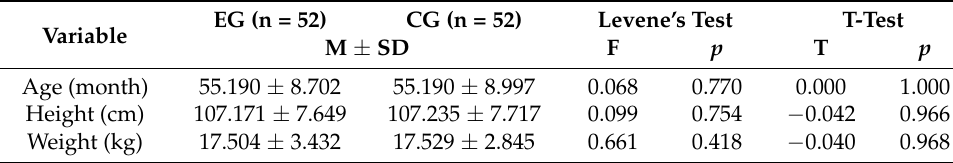
Table 1. Total subject variance homogeneity test.